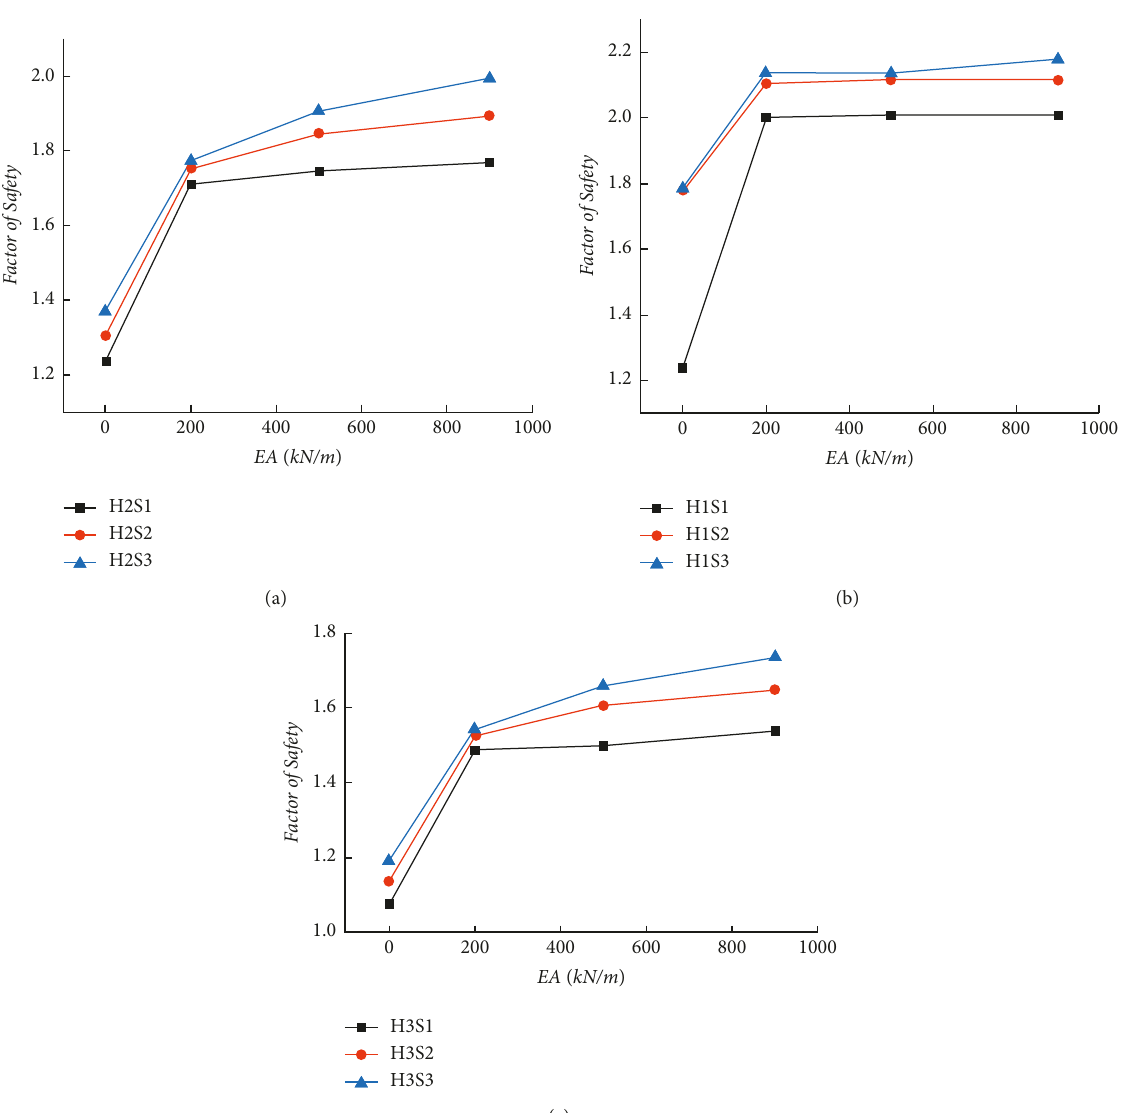
Figure 6: Effects of axial stiffness of geogrids on the factor of safety of the embankment (a) for H1, (b) for H2, and (c) for